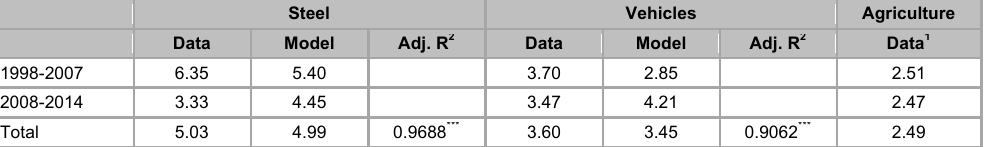
Percentage change in production, pre- and post-financial crisis Steel Vehicles